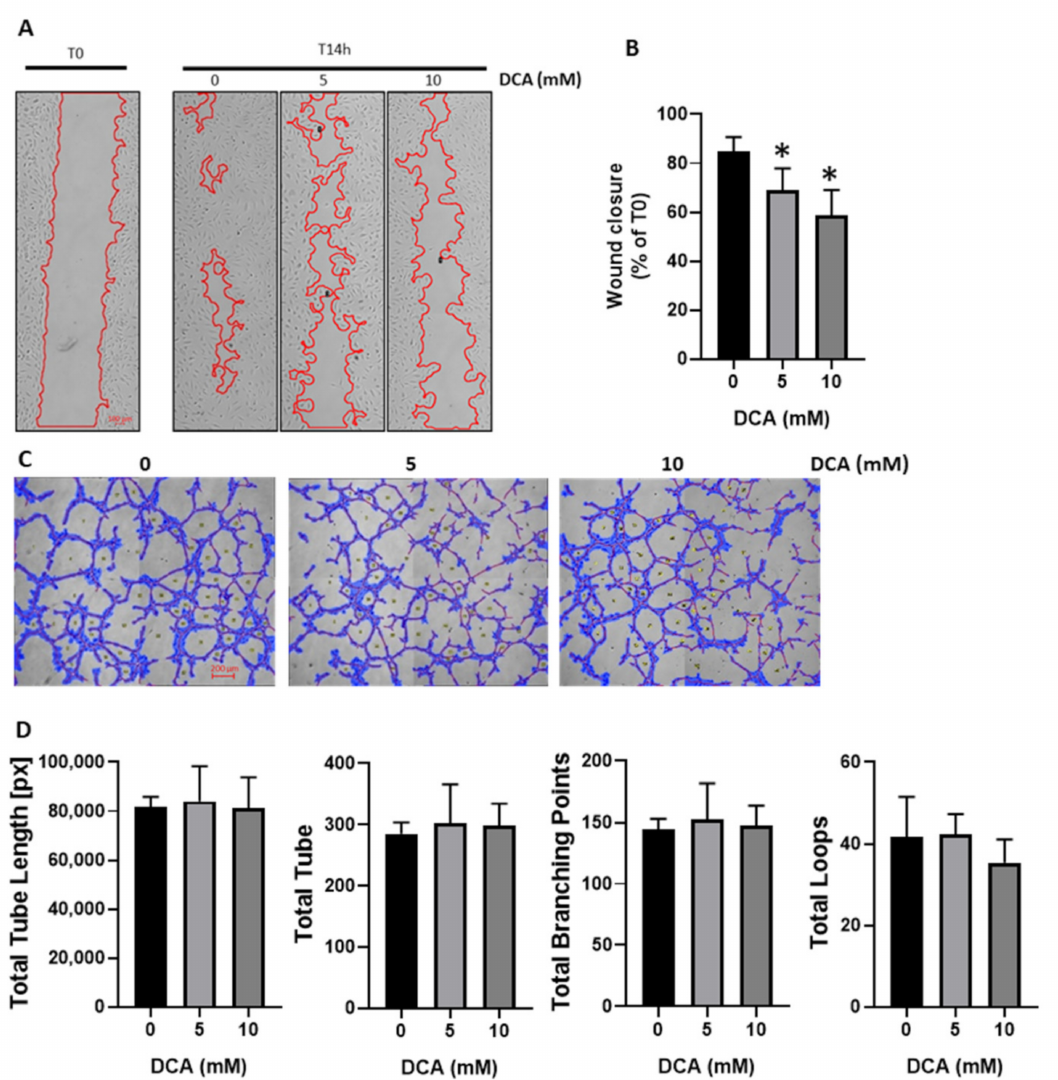
Figure 2. DCA reduces HUVECs migration without impact on tube formation. ( A , B ), Wound healing assays: HUVECs were pre-treated with mitomycin C and DCA treatment started when inserts were removed (T0), percentage of wound closure is calculated after 14 h (T14 h) of cell migration ( n = 4). A, representative phase contrast microphotographs of wound healing assay. B, percentage of wound closure after 14 h calculated from each T0 counterparts. ( C , D ), Tube formation assays: HUVECs were seeded on Matrigel for 4 h with or without DCA treatment ( n = 3). C, representative phase contrast microphotographs of tube formation assays. D, quantitative analysis of specific parameters (total tube length, total number of tubes, total branching point and total loops) of tube formation assays. Statistical analysis: One-way ANOVA ( B , D ) (Sidak’s multiple comparison test), * p <